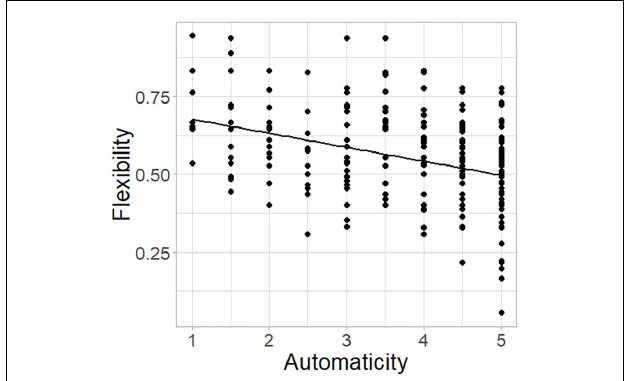
FIGURE 4 | Effect of self-reported automaticity on flexibility in the AUT. Overall effect of self-reported automaticity (range: 1–5) on flexibility (range: 0–1; p < 0.001) in the Alternative Uses Task (AUT). The regression line depicts the prediction made by the model. Data points are spread out to avoid overlapping, as participants were allowed to assign the same automaticity score to all types of objects equally.